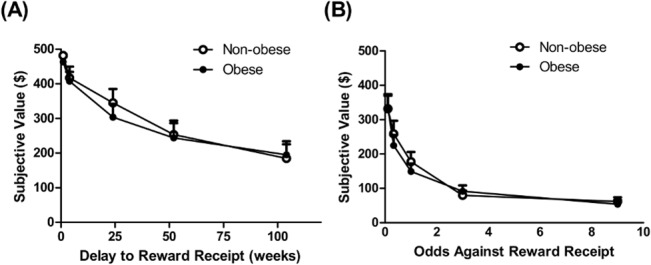
Non-obese and Obese Individuals Show Similar Reward Discounting Tendencies.(A) The subjective value of a monetary reward ($500) decreased as time to its receipt increased (main effect of time: F
4,120 = 54.10, p < .001) in a similar manner in non-obese and obese individuals (no main effect of group: F
1,30 = .12, p = 0.73 or group x time interaction (F
4,120 = .36, p = 0.84). (B) The subjective value of a monetary reward ($500) decreased as the odds against its receipt increased (main effect of time: F
4,120 = 88.66, p<0.001) in a similar fashion in non-obese and obese groups (no main effect of group: F
1,30 = .12, p = 0.73 or group x time interaction (F
4,120 = .67, p = 0.62).